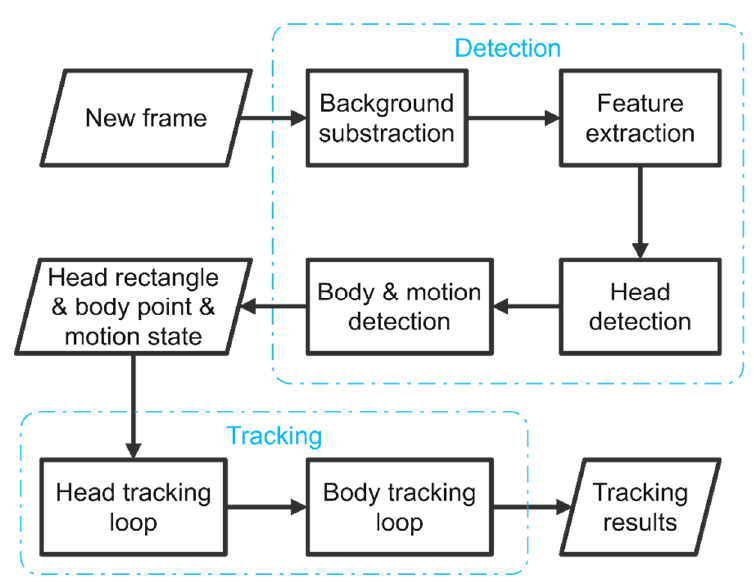
Figure 1. Flow chart of the proposed tracking scheme.